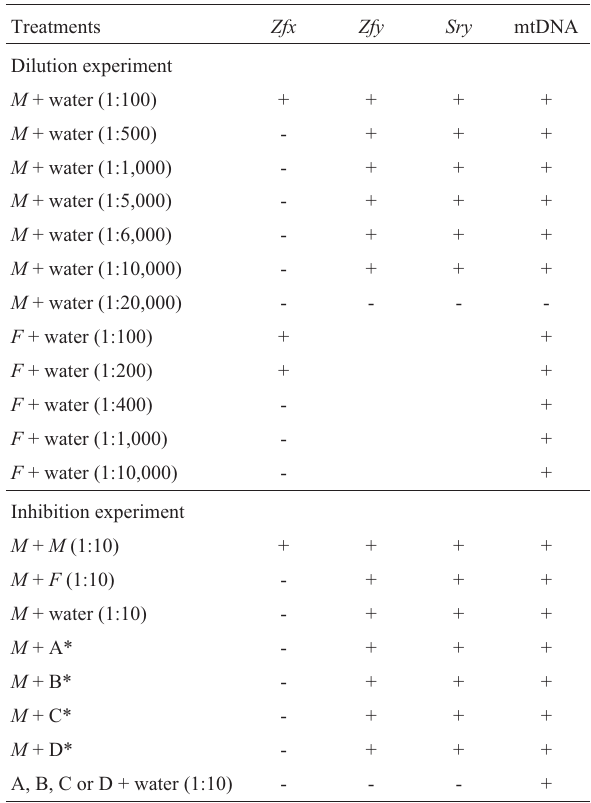
Table 1 - Results of dilution and inhibition experiments. Key: A, B, C and D, problematic samples; F, positive female; M, positive male.